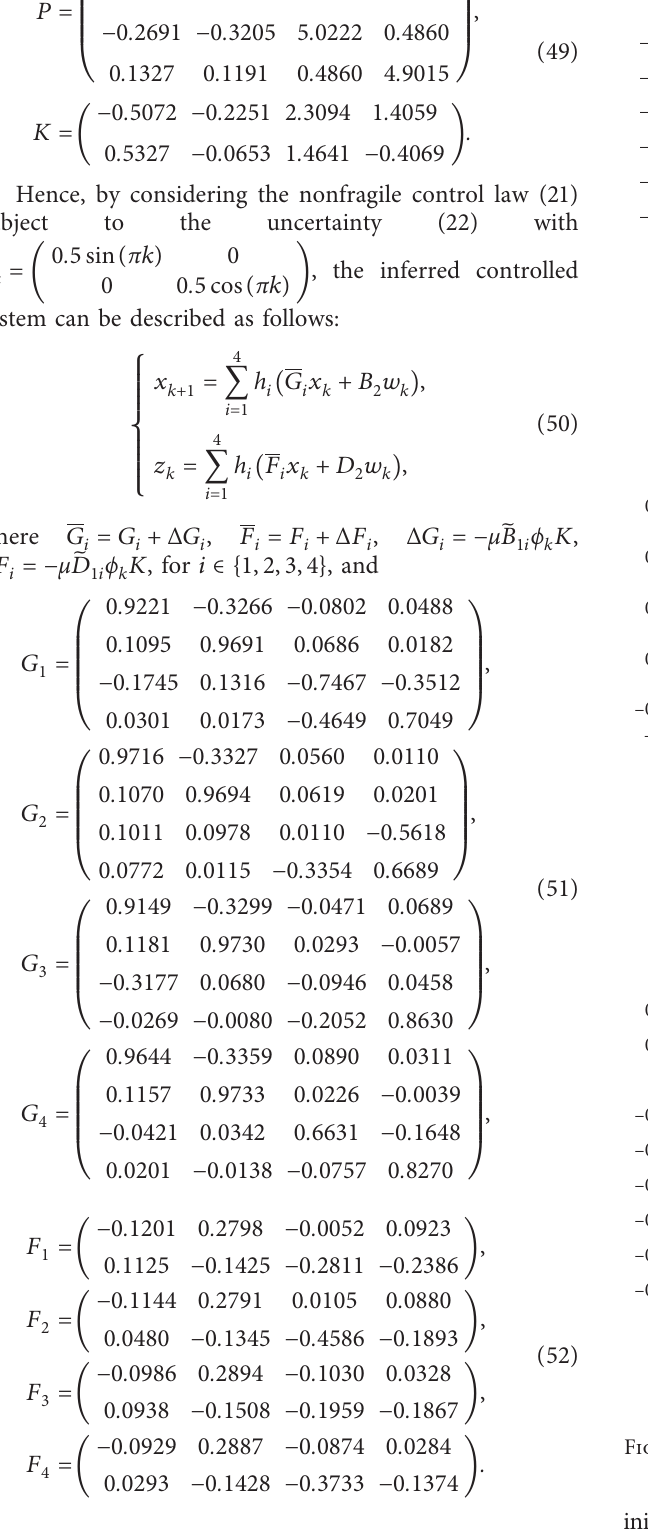
􏼁 ⊥ , where ( rand ) is a uniform number with a uniform distribution on the interval [ 0 , 0 . 01 ] , which is � − 0 . 15 if 50 ≤ kT ≤ 100 and 0 otherwise. added by w + k